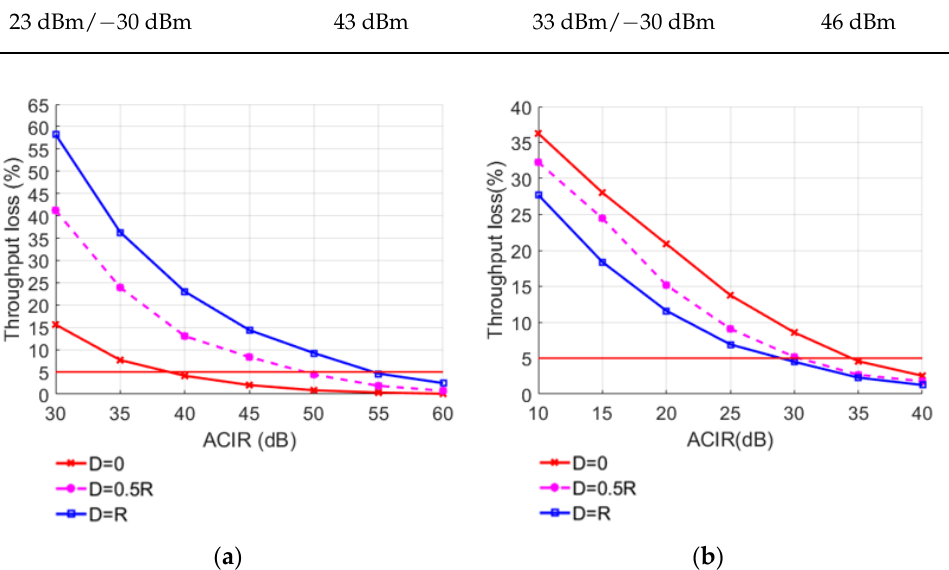
Figure 11. LTE-M throughput loss under different location offset between base stations and ACIR: ( a ) UE-BS, ( b ) UE-TE.